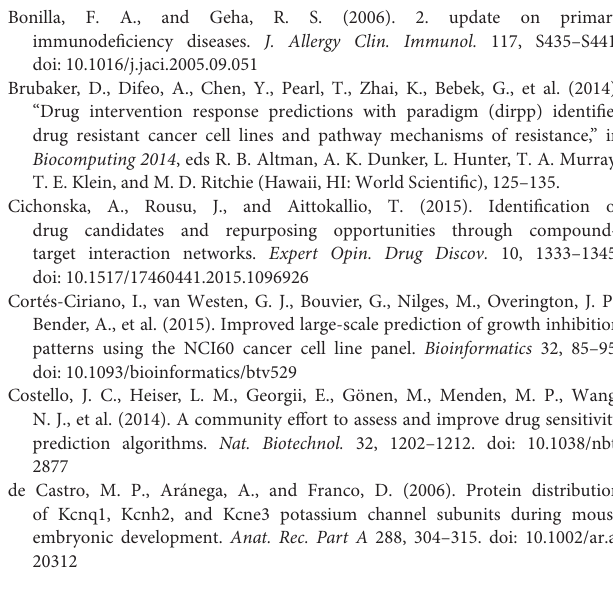
Supplementary File 1 | ROC curve of ten-fold cross validation. Supplementary File 2 | Selected features. Supplementary File 3 | Results of feature significance test. Supplementary File 4 | Function descriptions and interaction networks for PLX4720 and